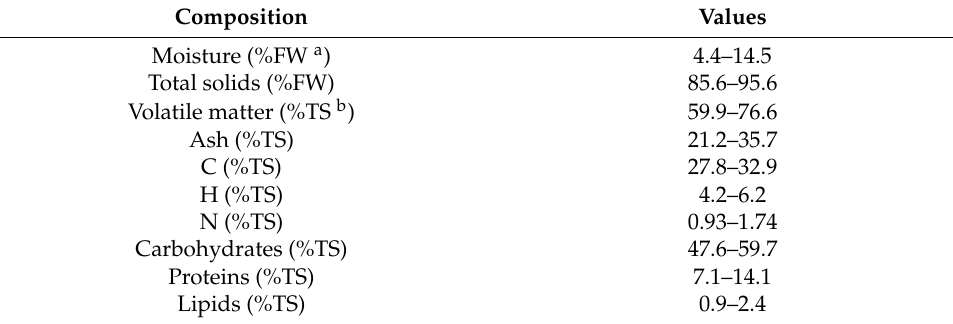
Table 1. Composition of S. japonica [34,38–45].